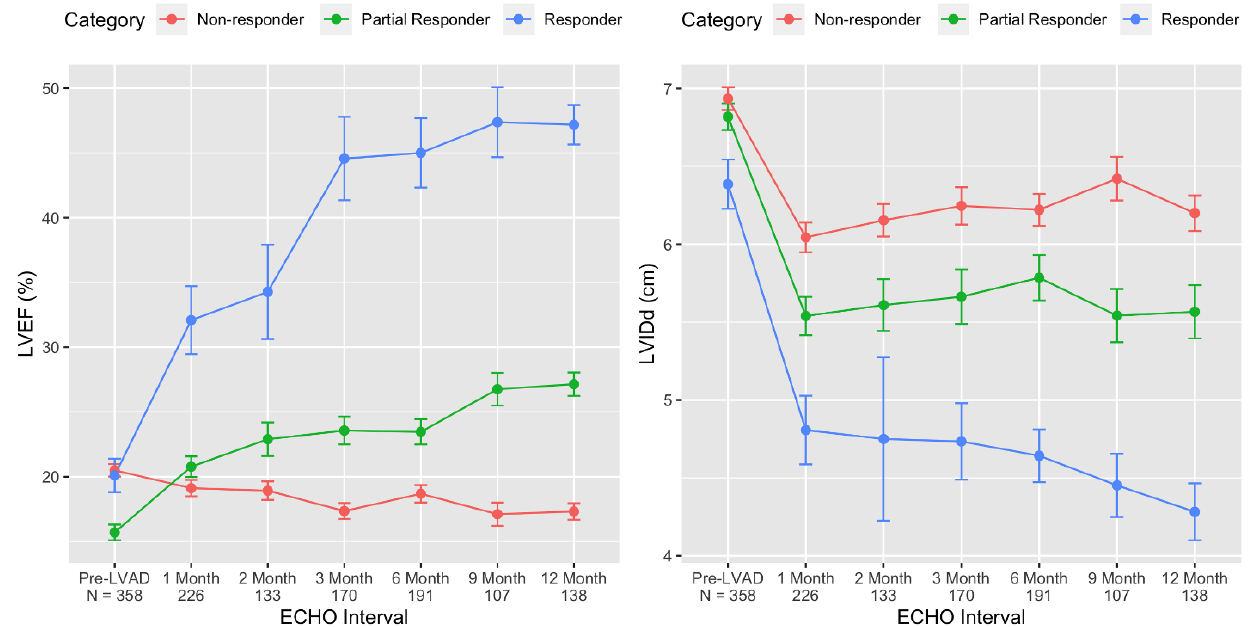
Figure 2. Time course of cardiac structural and functional improvement on LVAD support based on responder stage. By comparing the baseline and last follow-up echocardiogram, changes in the left ventricular ejection fraction (LVEF) and left ventricular internal dimension at end-diastole (LVIDd) were used to categorize LVAD patients into 3 distinct groups: responders (blue), partial responders (green), and non-responders (red). Using serial echocardiography, the change in function (LVEF) and structure (LVIDd) after LVAD implant are depicted by responder category. (Figure reproduced from Shah P et al. Framework to Classify Reverse Cardiac Remodeling with Mechanical